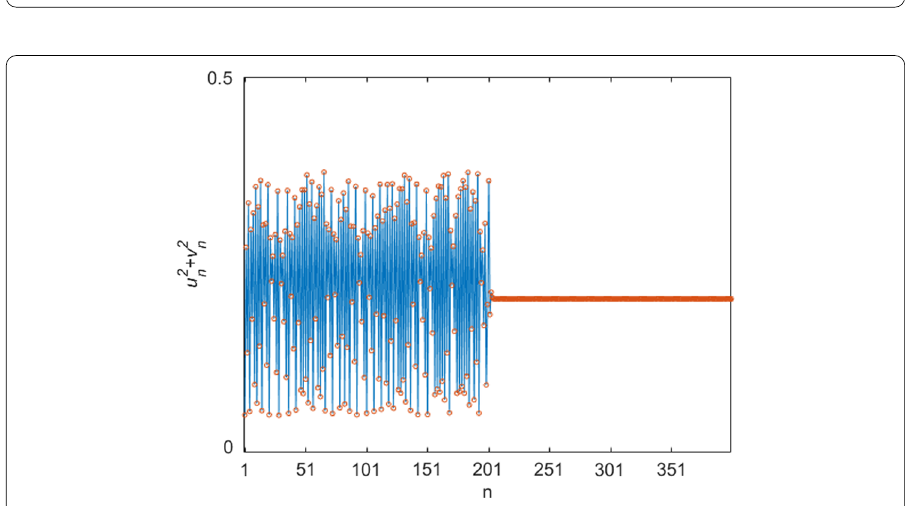
Figure 8 Time series data for controlled system (4.6) for s = 3, m = 3, β = 0.2, e 1 = 1.2, e 2 = 0.3, k 1 = –0.843221746 and k 2 = –0.929757409. The initial value is (0.1,0.2) and the control is activated after the 200th